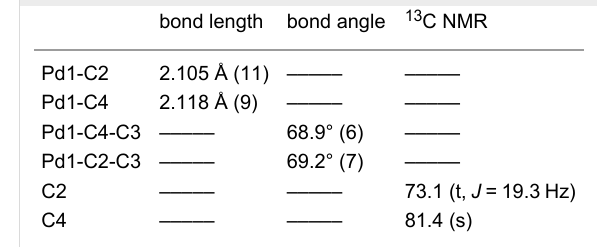
Table 1: Selected bond lengths (Å), bond angle ( o ) and chemical shifts of 13 C NMR spectroscopy of the trans - trans dimer 8